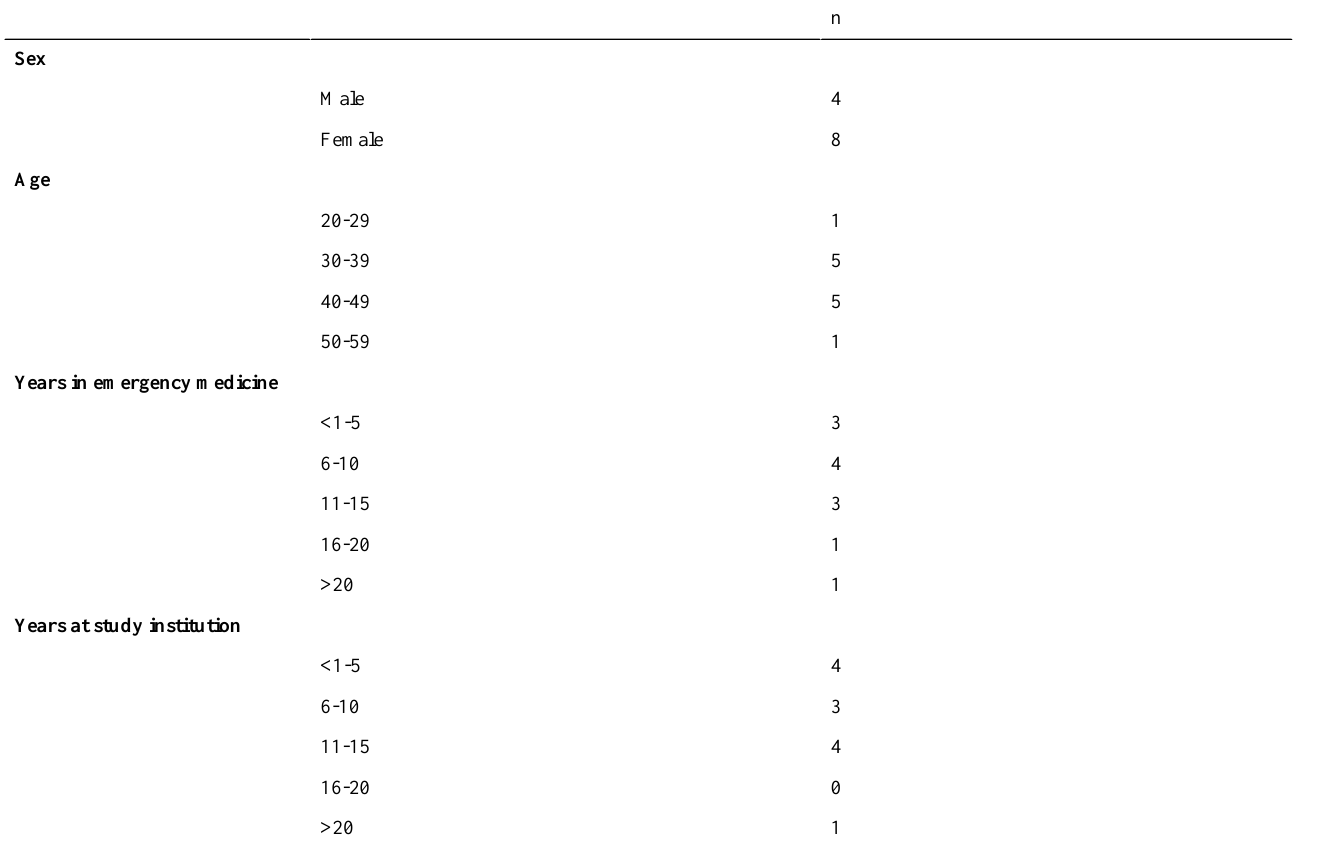
Table 1. Demographics of ED